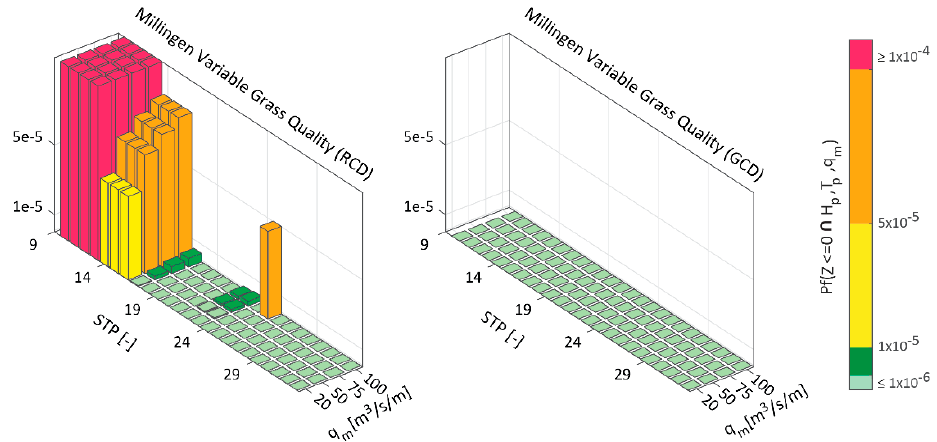
Figure 15. Failure probabilities per storm at each STP for the Millingen estimated grass quality per location for the RCD (Left side bar plot) and for the GCD (Left side bar plot). Bars in read coincide with locations in failure state before the storm condition was routed.